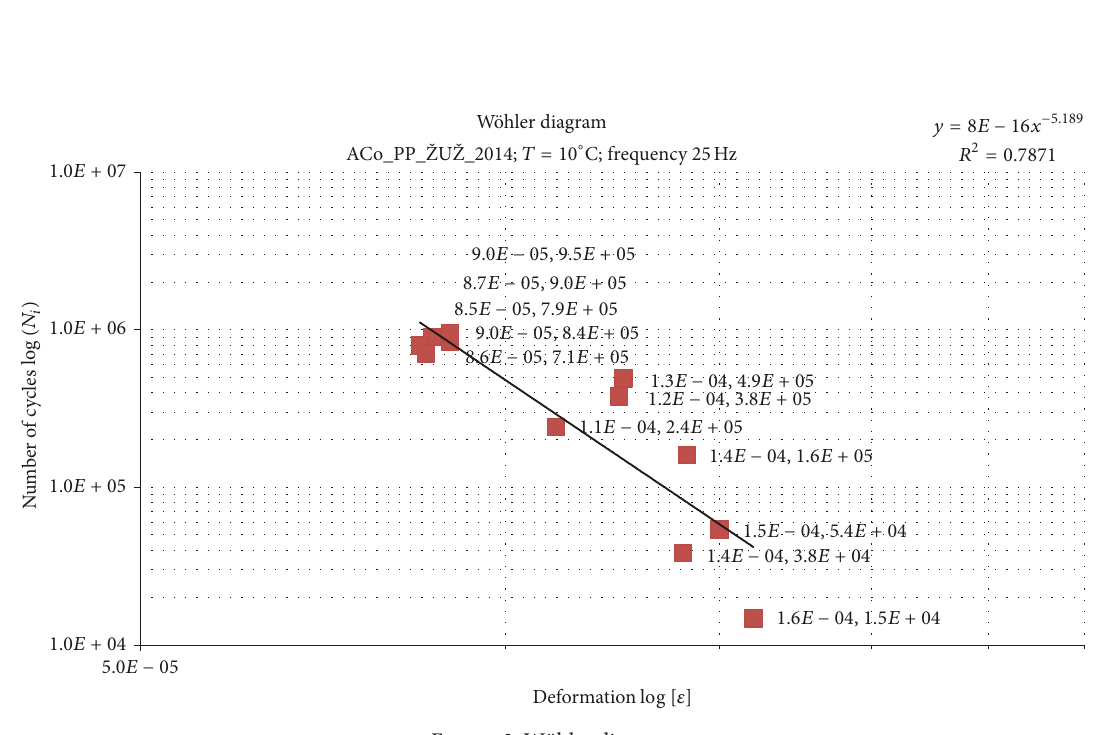
Figure 2: W¨ohler